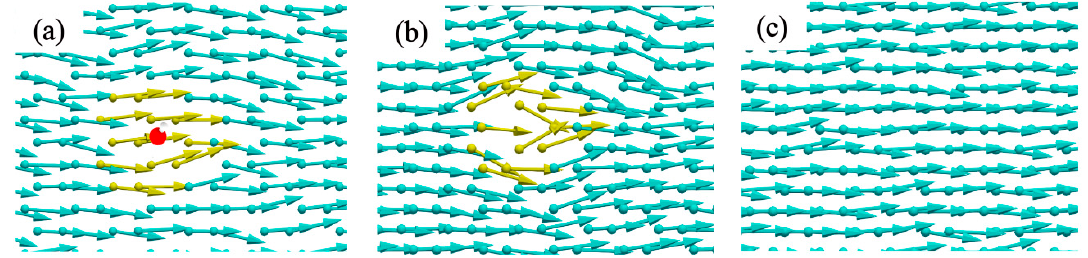
Figure 9. Spatial distribution of heat flux by vector arrows on each atom under non-equilibrium steady state. ( a ) A hydroxyl group, ( b ) one single vacancy, ( c ) graphene.